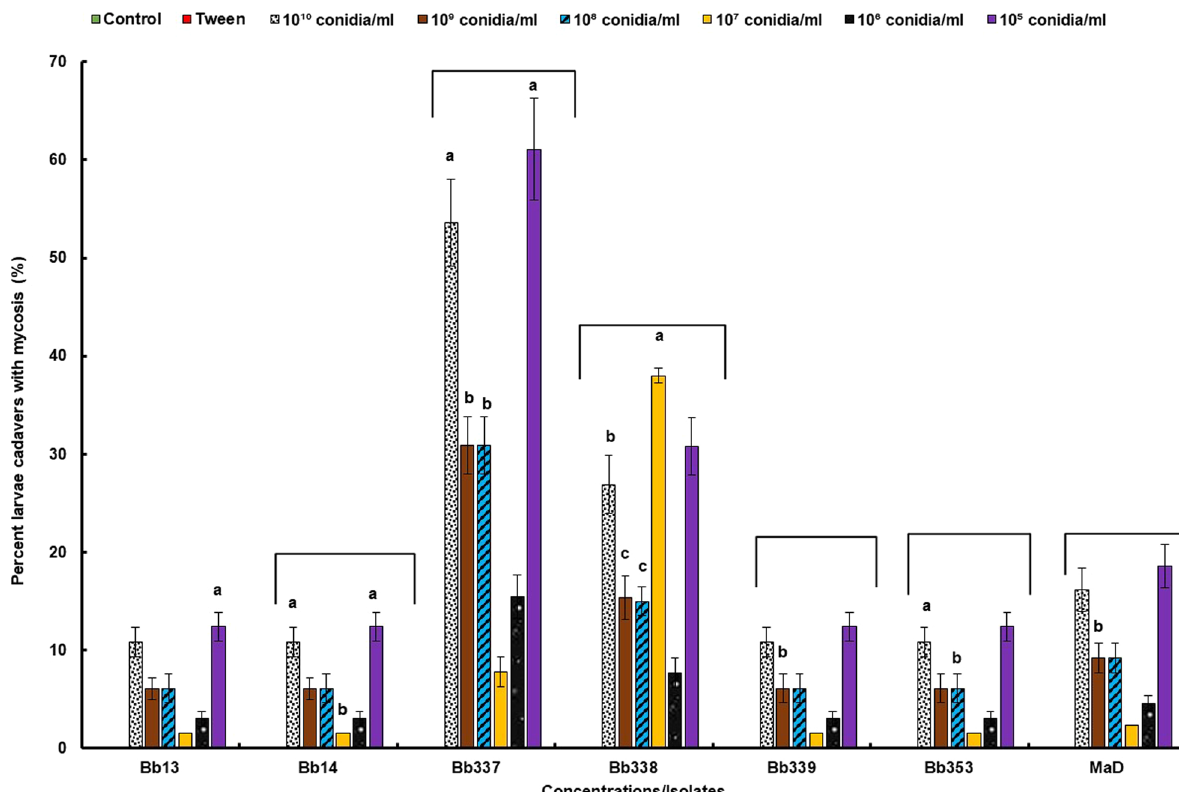
Fig. 4 Cadavers of Zeugodacus cucurbitae larvae with fungal growth after treatment different concentrations of isolates of Beauveria bassiana and Metarhizium anisopliae in larval inoculation